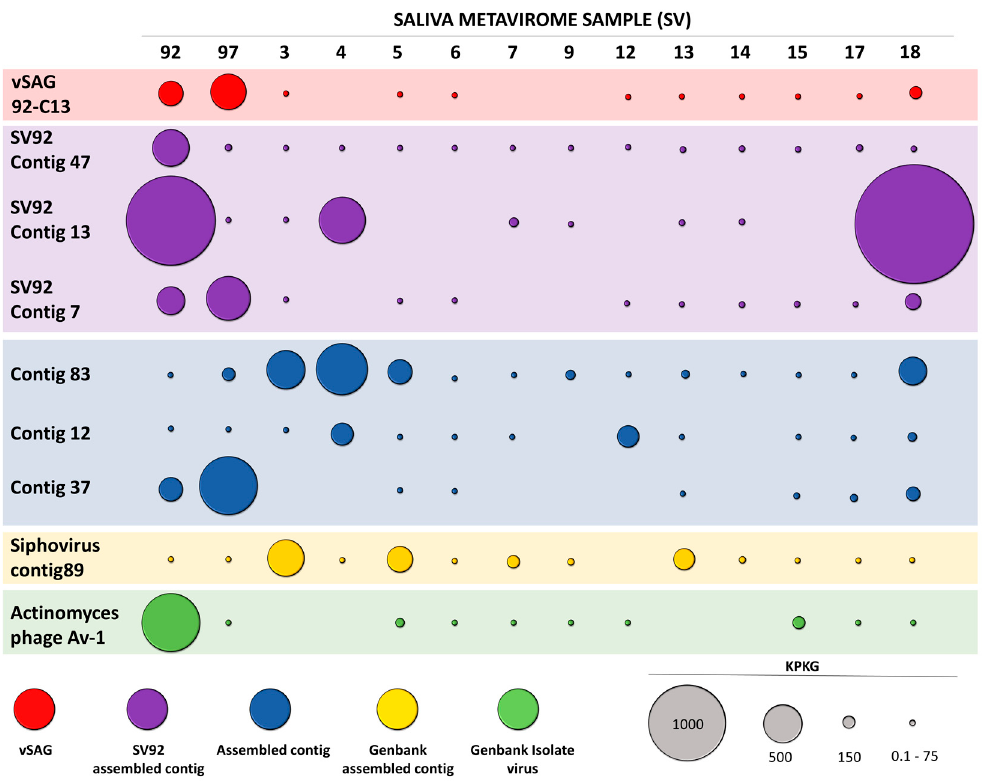
Figure 4. Abundance and ubiquity of viruses from the oral cavity. Virome fragment recruitment of nine of the most abundant oral viruses, obtained using different techniques, is shown. Circle color differentiates the viral genomes obtained from: single-virus genomics (red; this study); assembled data from our salivary virome samples (purple); reassembled data from previously published salivary viromes (blue) [18]; assembled viral contigs by Pride and colleagues [18], and viral isolates from the Genbank database (green). The size of the circle depicts the recruitment rate, expressed in kilobases recruited from each virome (Kb), and normalized by the viral genome length (kb) and the virome size (Gb) (KPKG). Only reads with ≥ 70% identity and query coverage and viruses with ≥ 40% coverage (subject coverage) were considered. Absence of a circle indicates no recruitment or recruitment below applied thresholds. As the sequencing reaction for virome sample SV108 failed, there are a total of 14 viromes included in these analyses.